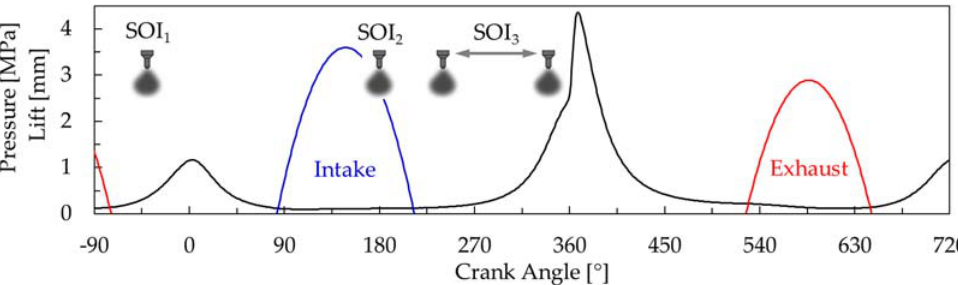
Figure 2. Example of in ‐ cylinder pressure, profiles of valve lifts and injection timings.